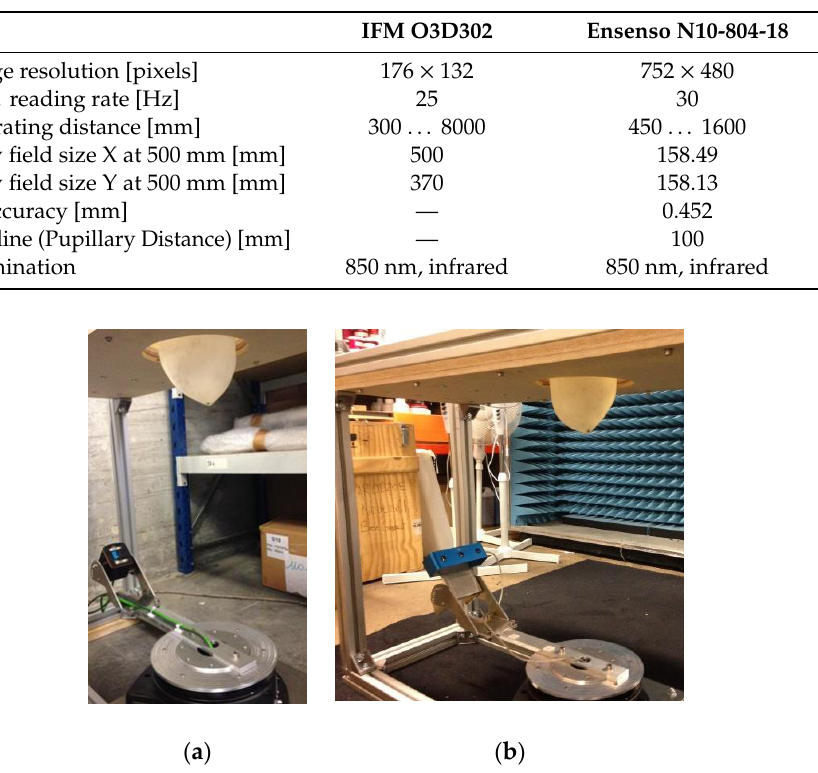
Table A1. Main technical data of the two tested cameras.